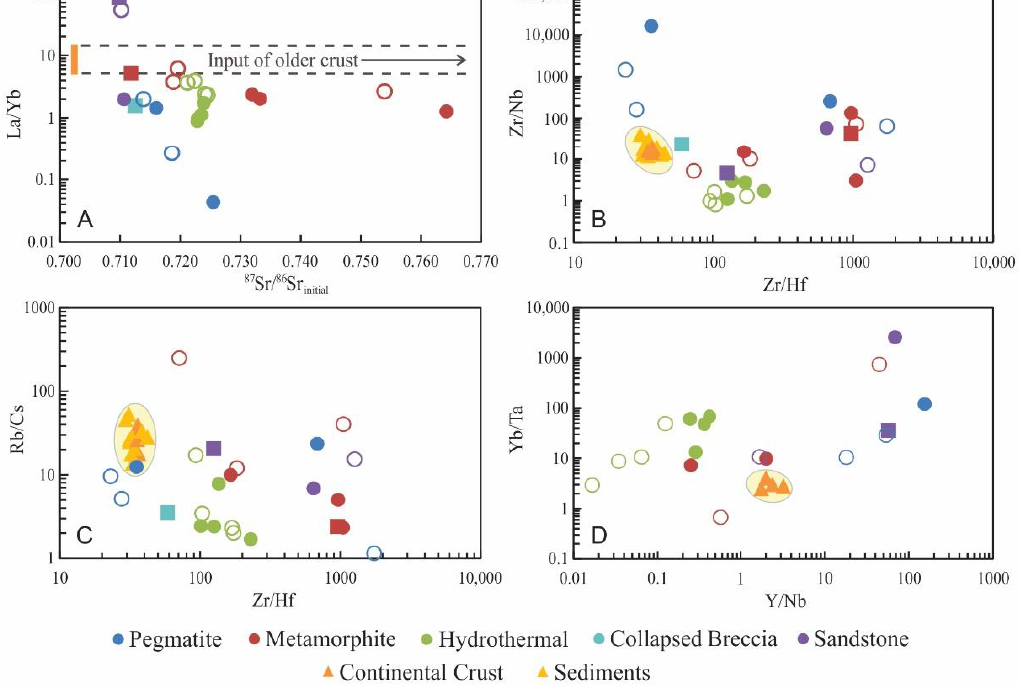
Figure 1. Binary plots illustrating trace element concentration ratios (determined using solution mode ICP-MS) for uraninite based on deposit type. ( A ) 87 Sr / 86 Sr initial vs. La / Yb, orange rectangle indicates range of La / Yb values for continental crust; ( B ) Zr / Hf vs. Zr / Nb; ( C ) Zr / Hf vs. Rb / Cs; ( D ) Y / Nb vs. Yb / Ta. Solid circles represent pristine fraction of uraninite, whereas open circles denote altered areas, and square symbols indicate bulk aliquots as pristine and altered segments could not be physically separated. The yellow fields (orange triangles) denote values for crust [52] and sediment [53,54].